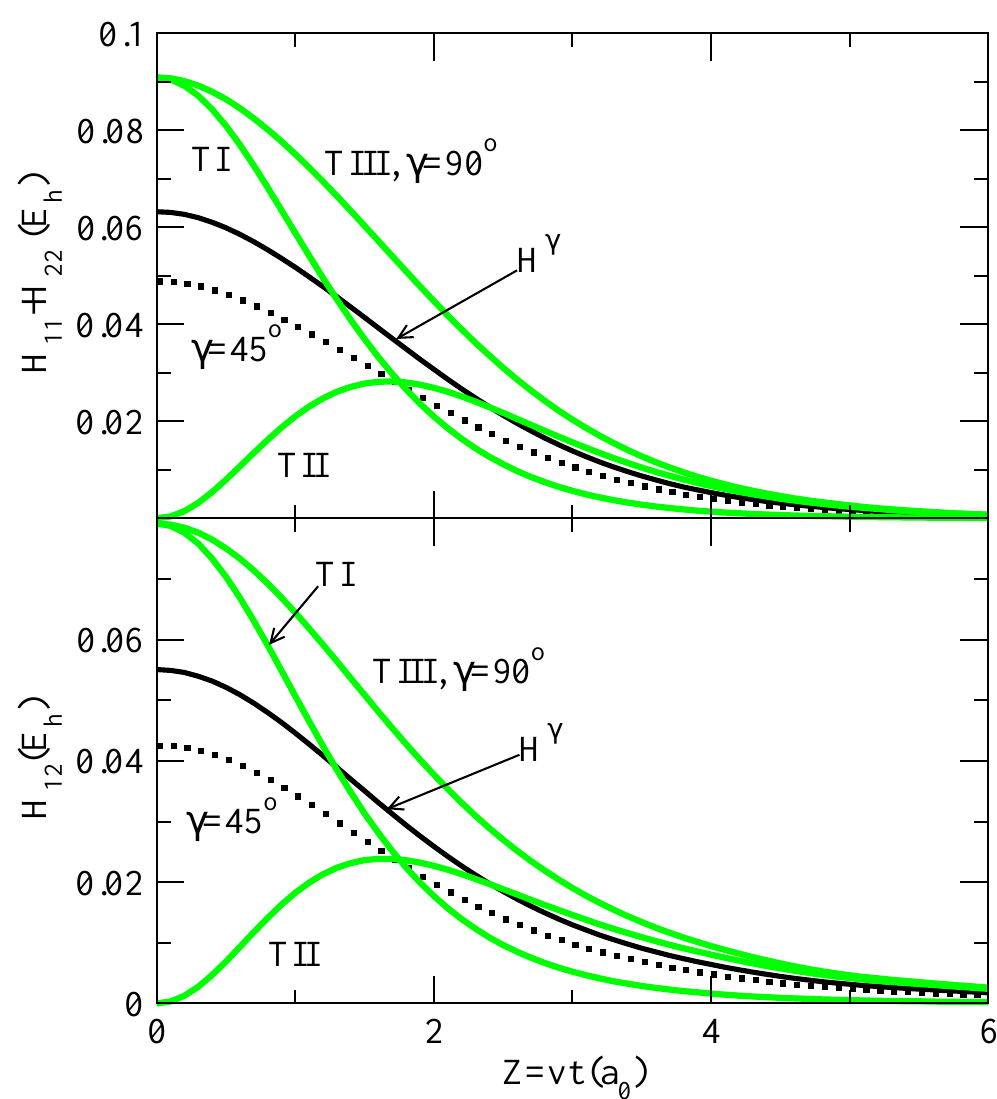
√ ( R, γ ) as functions of Z (= vt = R 2 − b 2 ) for several ij − H − H ]( R, γ ) − [ H ]( R, γ = 0). Bottom 22 11 22 11 ( R, γ ) − H ( R, γ = 12 12